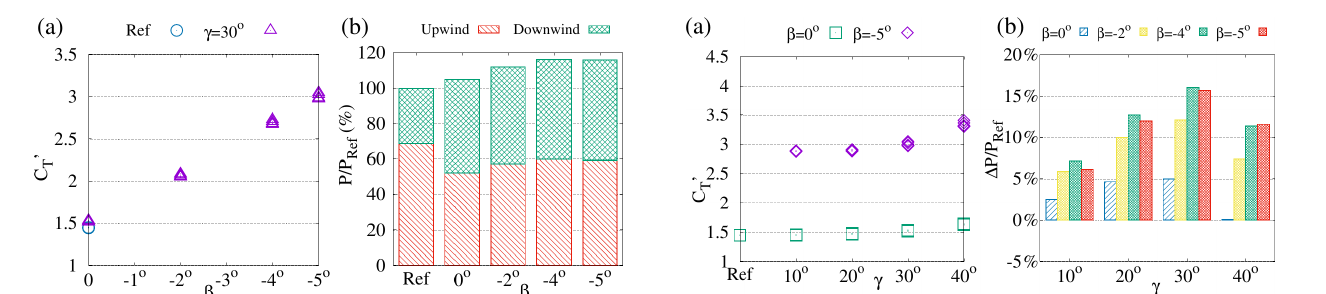
Figure 8. Effect of changing the rotor-collective blade-pitch angle β of turbines yawed by γ = 30 ◦ . (a) Local thrust coefficient C (cid:48) the turbines of the upwind row. (b) Wind power extracted by the upwind (hatched red) and downwind (cross-hatched green) rows of turbines normalized by the total power P Ref extracted in the base- line case.